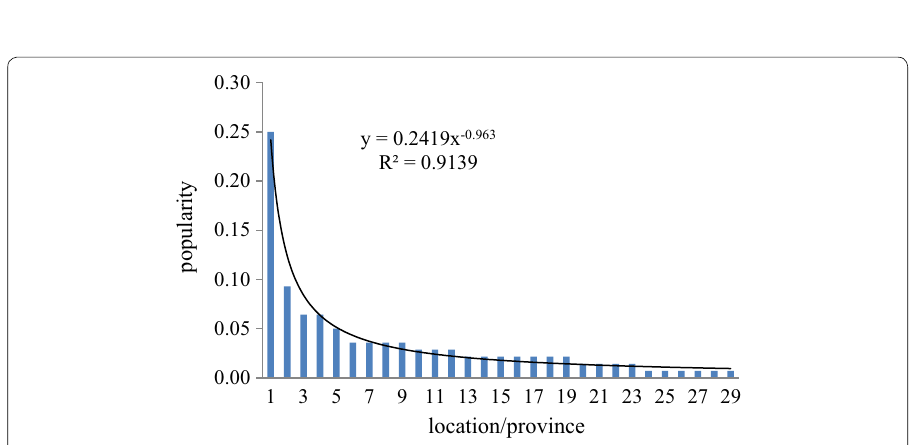
Fig. 2 A map of topic spatial popularity. This figure indicates the popularity distribution in